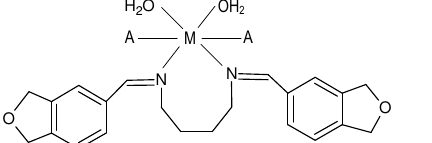
Figure 5. Structure suggested for MLA CH COO - , Cl - , Br - , NO 3- or ClO 4- 3